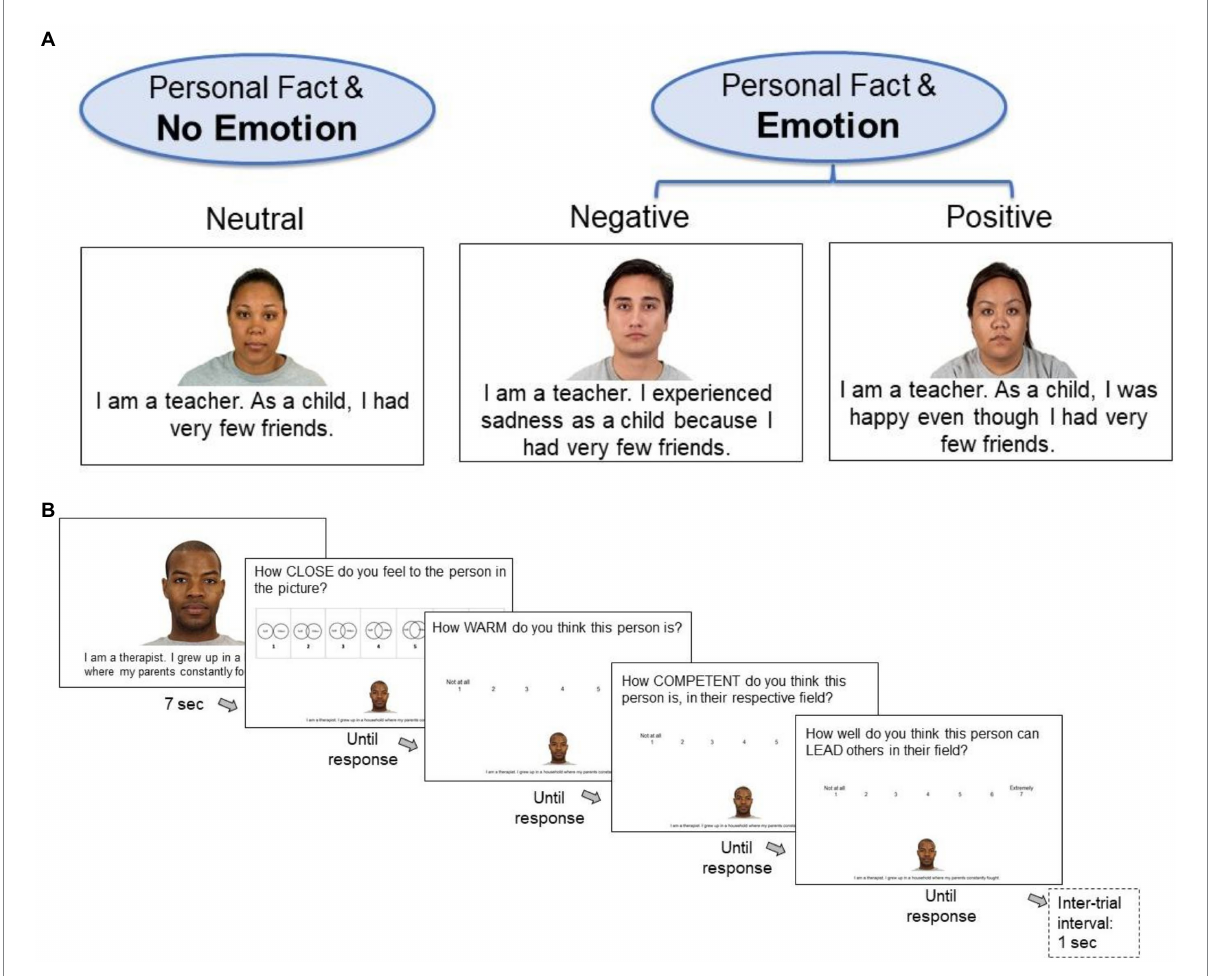
FIGURE 2 Experimental Design. (A) Example stimuli for the three conditions. All participants saw personal statements without emotion (NoEmotion condition) in half of the trials of the experiment (16 trials). During the other half of the trials (16 trials), half of participants saw the same statements with a negative emotion and the other half of participants saw them with a positive emotion (Emotion condition). Pictures of faces were kindly provided by the Chicago Face Database (Ma et al., 2015), reproduced with permission. (B) Depiction of one trial. Participants saw headshots of people with a short statement about their profession, with autobiographical information from their past, and—on Emotion-trials—with the report of a positive or negative emotion with regards to that personal information. They then rated closeness, warmth, competence, and leadership ability of the